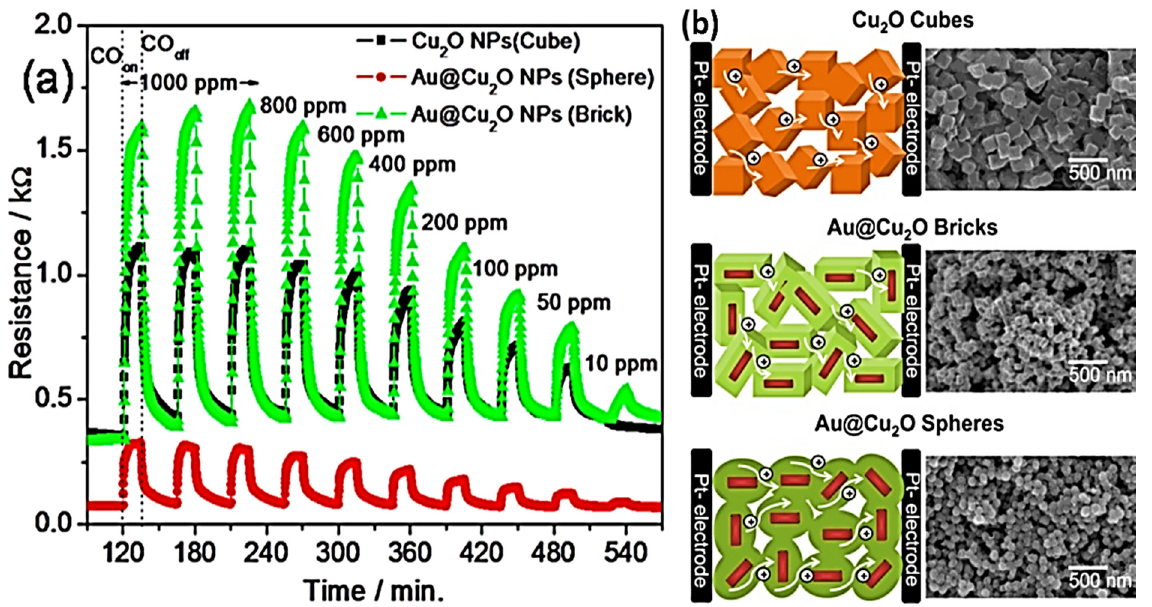
Figure 12. ( a ) Dynamic resistance curves of different Cu 2 O gas sensors for CO gas and ( b ) the sensing mechanism of different gas sensors. Reproduced from [89] with the permission of Elsevier.